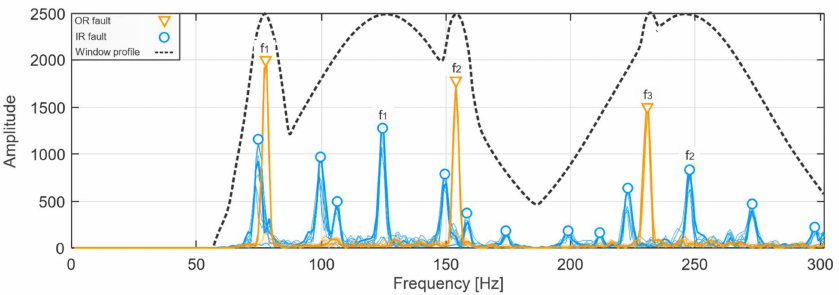
Figure 12. Merged OR and IR signal envelope power spectra after multiplication with OR and IR window sets.